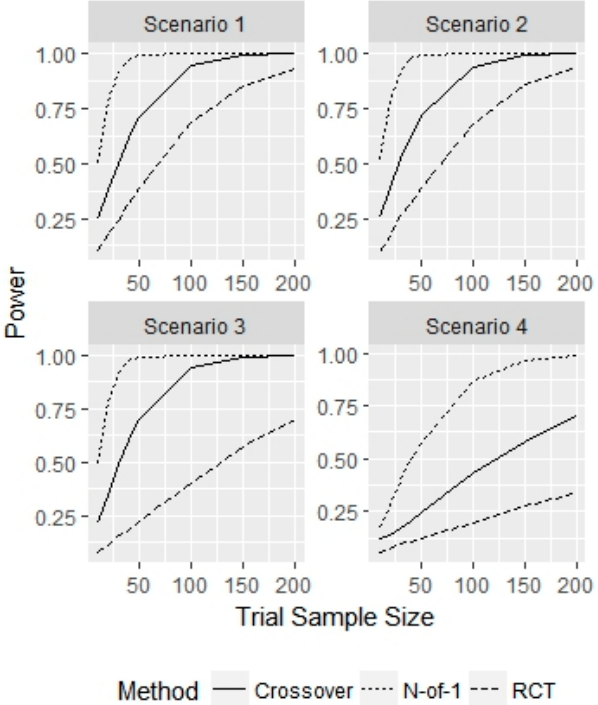
Figure 1. Simulation study for representative sample without washout effects. This figure displays the power for detecting 𝜏 = 0.25 for given sample sizes and the three different designs